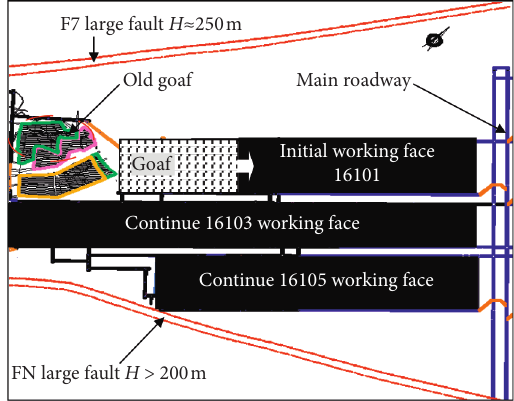
Figure 2: Layout plan of the initial working face